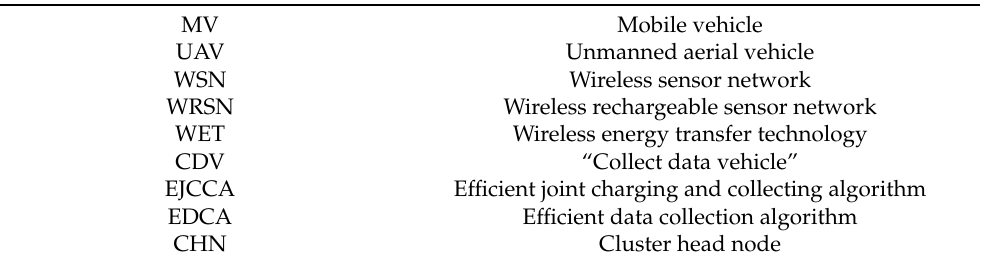
Table 2. A list of